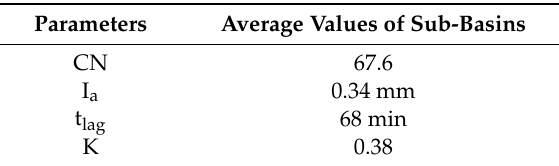
Table 5. Calibrated parameters of